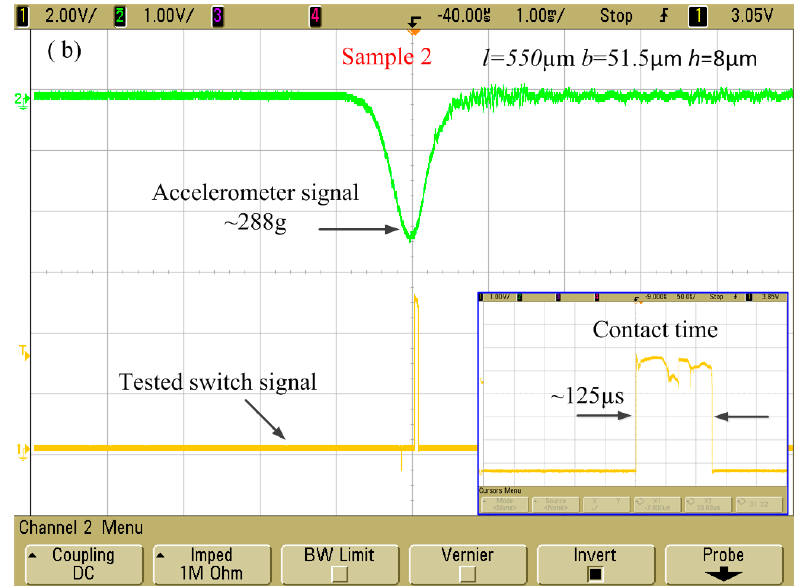
Figure 16. Test results of the inertial microswitches under the shock acceleration amplitude of 288 g: ( a ) The geometric parameters (l , b , h ) of the stationary electrode are 550 µm, 51.5 µm, and 12 µm in sample 1; (b ) The geometric parameters ( l , b , h ) of the stationary electrode are 550 µm, 51.5 µm, and 8 µm in sample 2.